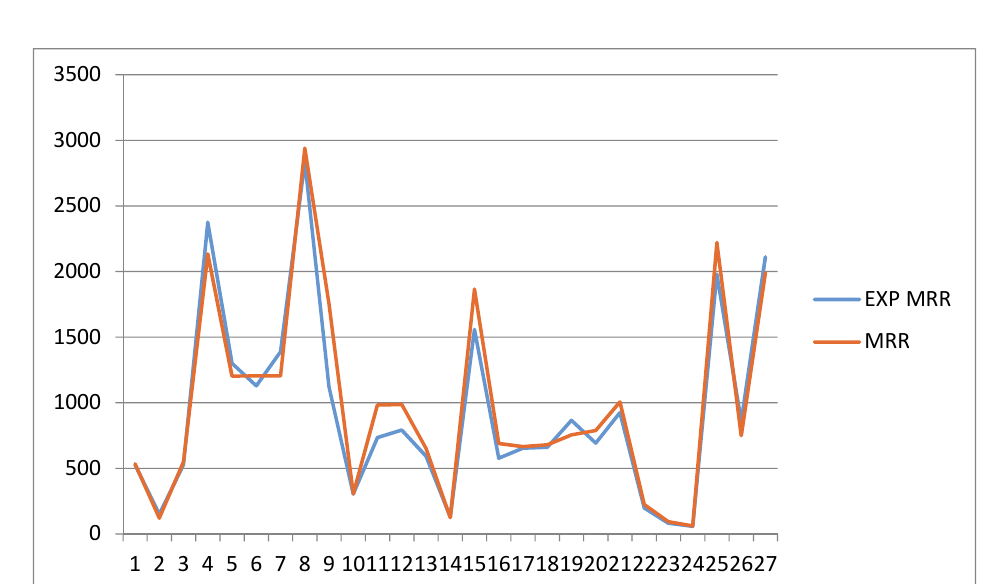
Fig. 11. Experimental MRR Vs ANN